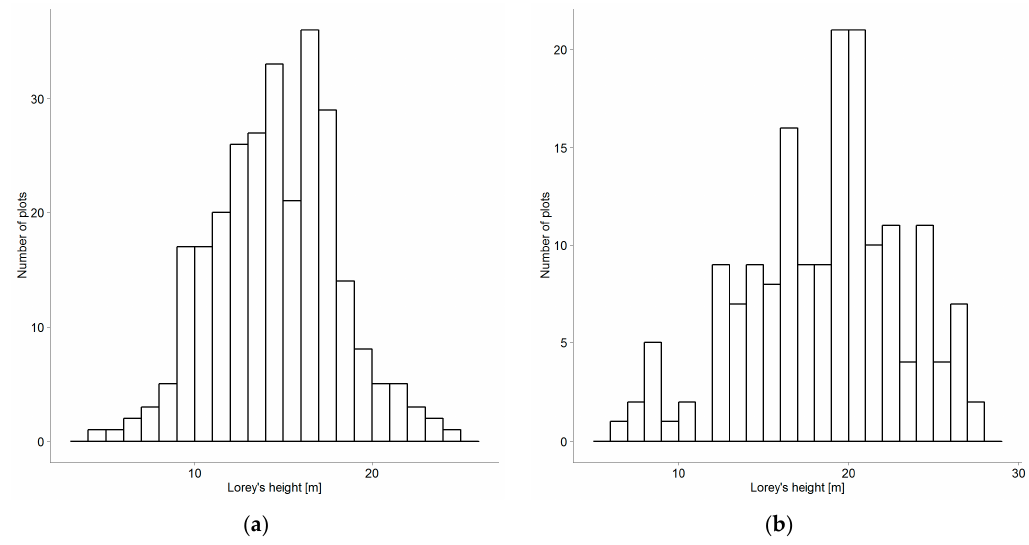
Figure 3. Height distribution of Lorey’s mean height for the field plots at respective test site: ( a ) Krycklan; ( b ) Remningstorp. Table 1. Properties for the reference dataset. SD denotes standard deviation.